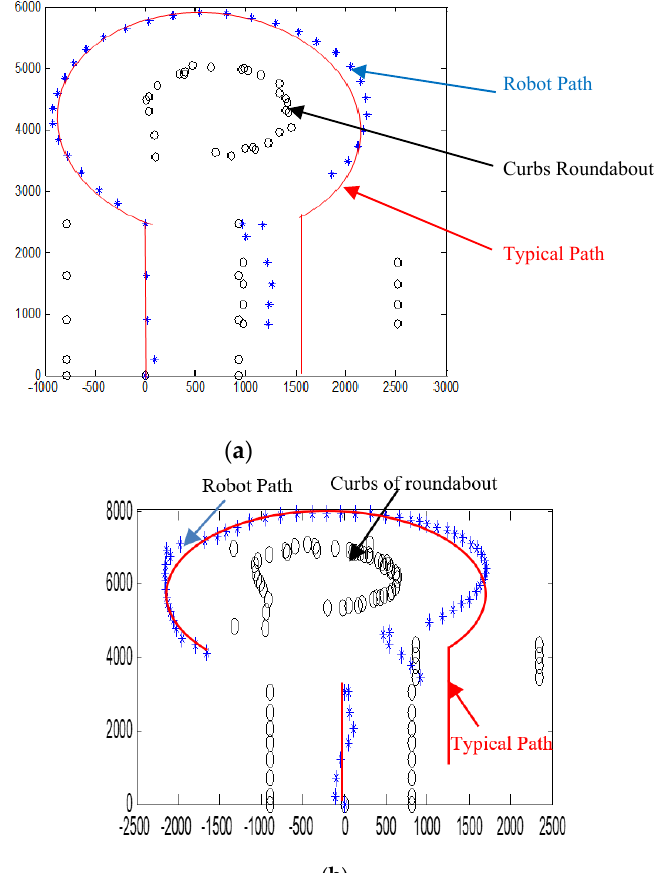
Figure 25. Robot path during navigation in a roundabout with 360° rotation. Note that blue ‘*’ denotes